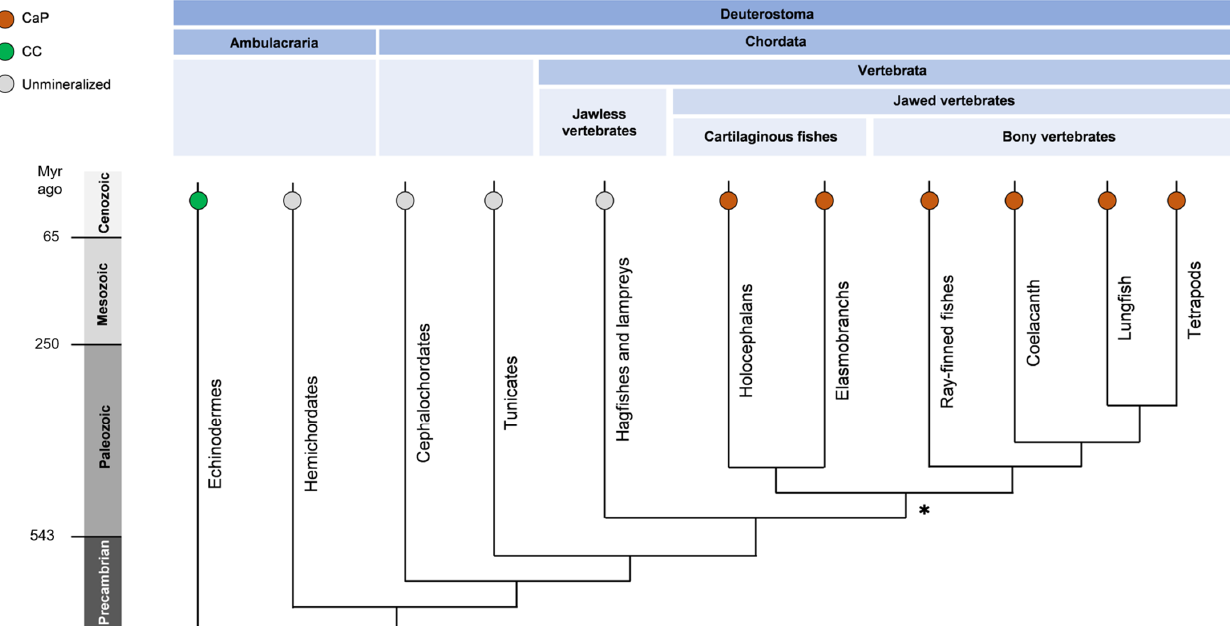
Figure 1. A simplified phylogenetic tree of deuterostomia showing the composition of animal skeletons (CaP: calcium phosphate; CC: calcium carbonate, or unmineralized). Bony vertebrates and cartilaginous fishes are the dominating living vertebrates (gnathostomes, 99.9%). Cartilaginous fishes produce dermal skeleton, including teeth dermal denticle and fin spine, but not endochondral bone as bony vertebrates. Lampreys and hagfishes (cyclostomes) lack, however, mineralized tissues. The emergence of hinged jaws and the mineralized skeleton, indicated by (*), is a major event in the evolution of vertebrates. Adapted from [6]. The composition of the mineral phase was found in [5].